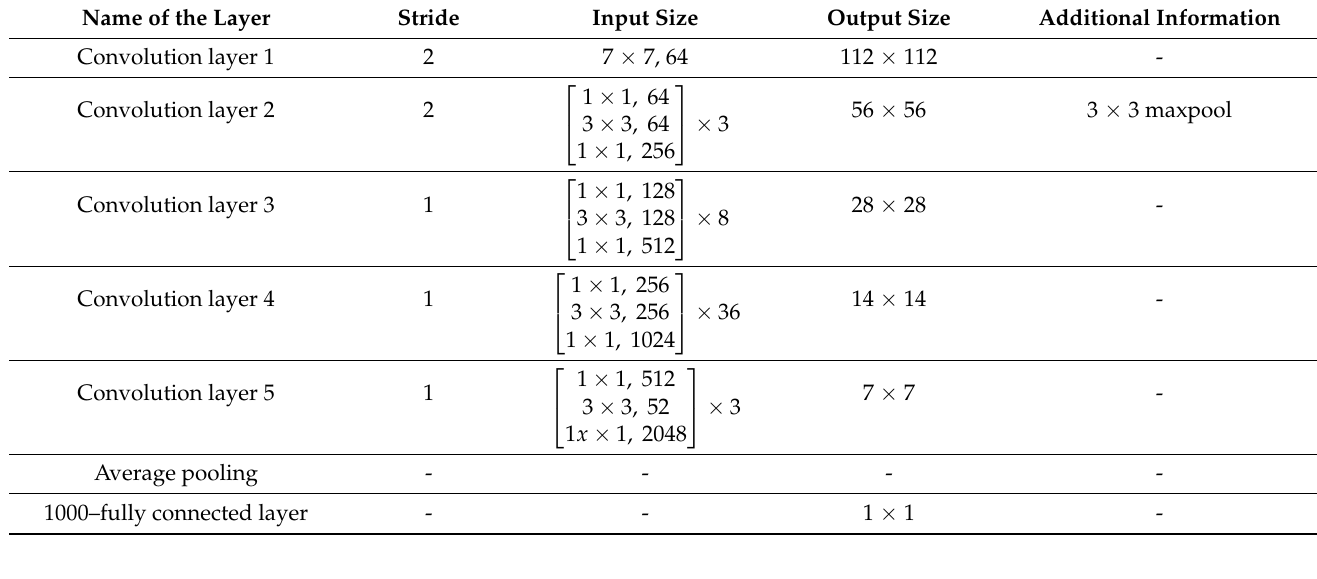
Table 1. Details of ResNet-152 layers.